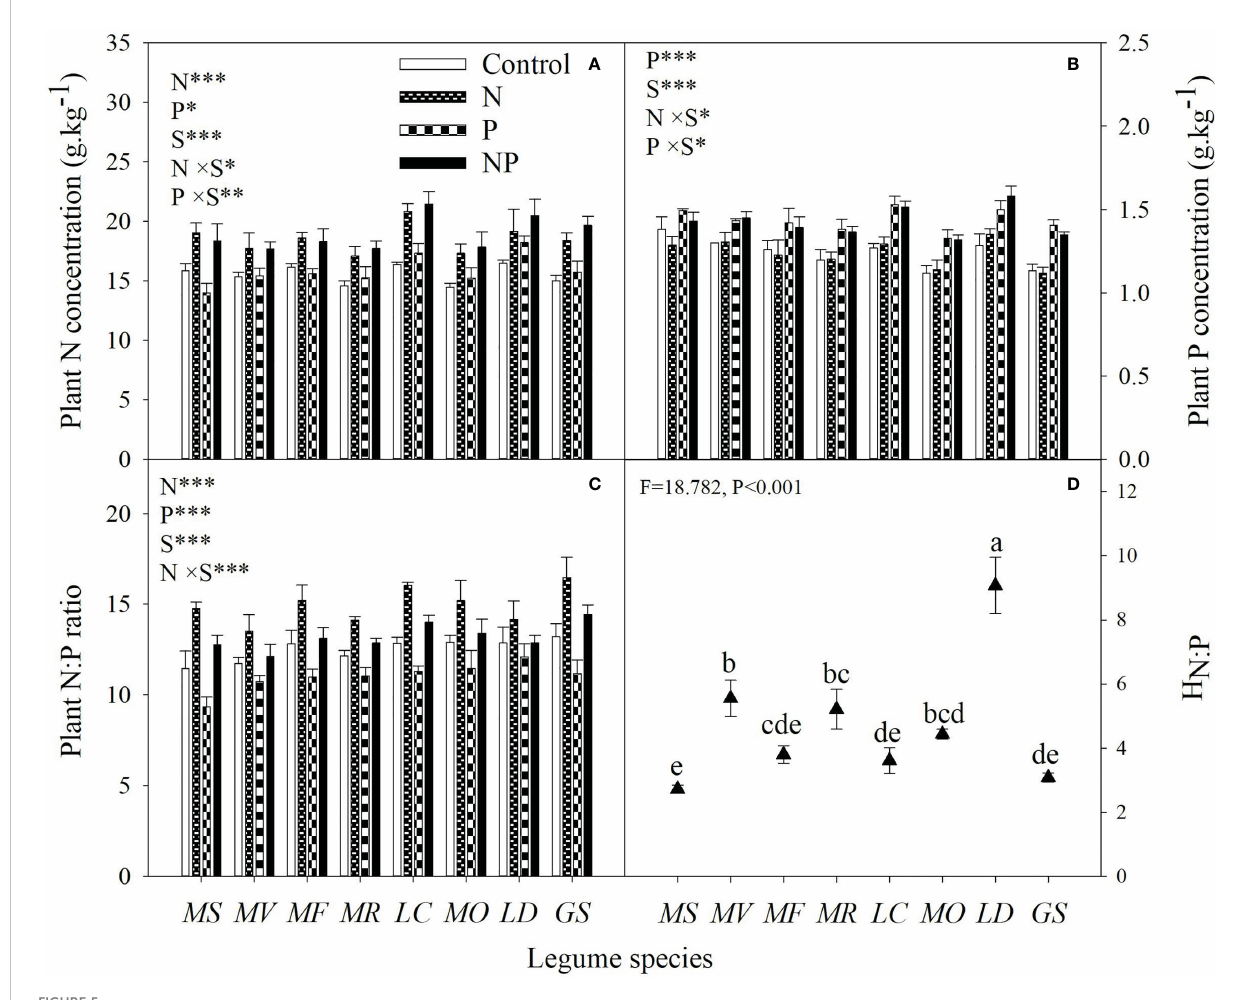
FIGURE 5 Plant N concentration (A) , plant P concentration (B) , plant N:P ratio (C) under control (no fertilizer addition), N (N addition), P (P addition) and NP (addition of both N and P), and stoichiometric homeostasis of plant N:P (H N:P , d) for eight legume species. MS, Medicago sativa ; MV, Medicago varia ; MF, Medicago falcata ; MR, Medicago ruthenica ; LC, Lotus corniculatus ; MO, Melilotus of fi cinalis ; LD, Lespedeza daurica ; GS, Glycine soja. Letters (N, P, S, N×P, N×S, P×S, N×P×S) indicate signi fi cance overall from N addition, P addition, legume species (S) and their interaction effects according to general linear model P-values, the signi fi cance level are reported as ***(P<0.001), **(P<0.01), *(P<0.05). Inside the embedded fi gures, the bars represent the means of each independent factor and interacted treatment with signi fi cant effect. Solid triangles without a common lowercase letter differed according to Duncan ’ s multiple comparison test